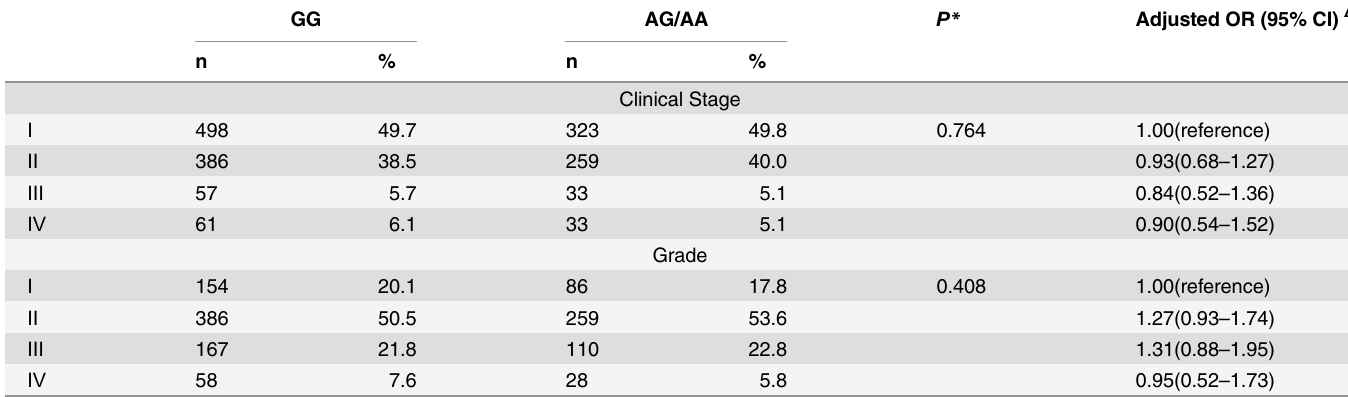
Table 6. The association of Cav1 rs1049334 polymorphism and clinicopathologic characteristics of ccRCC